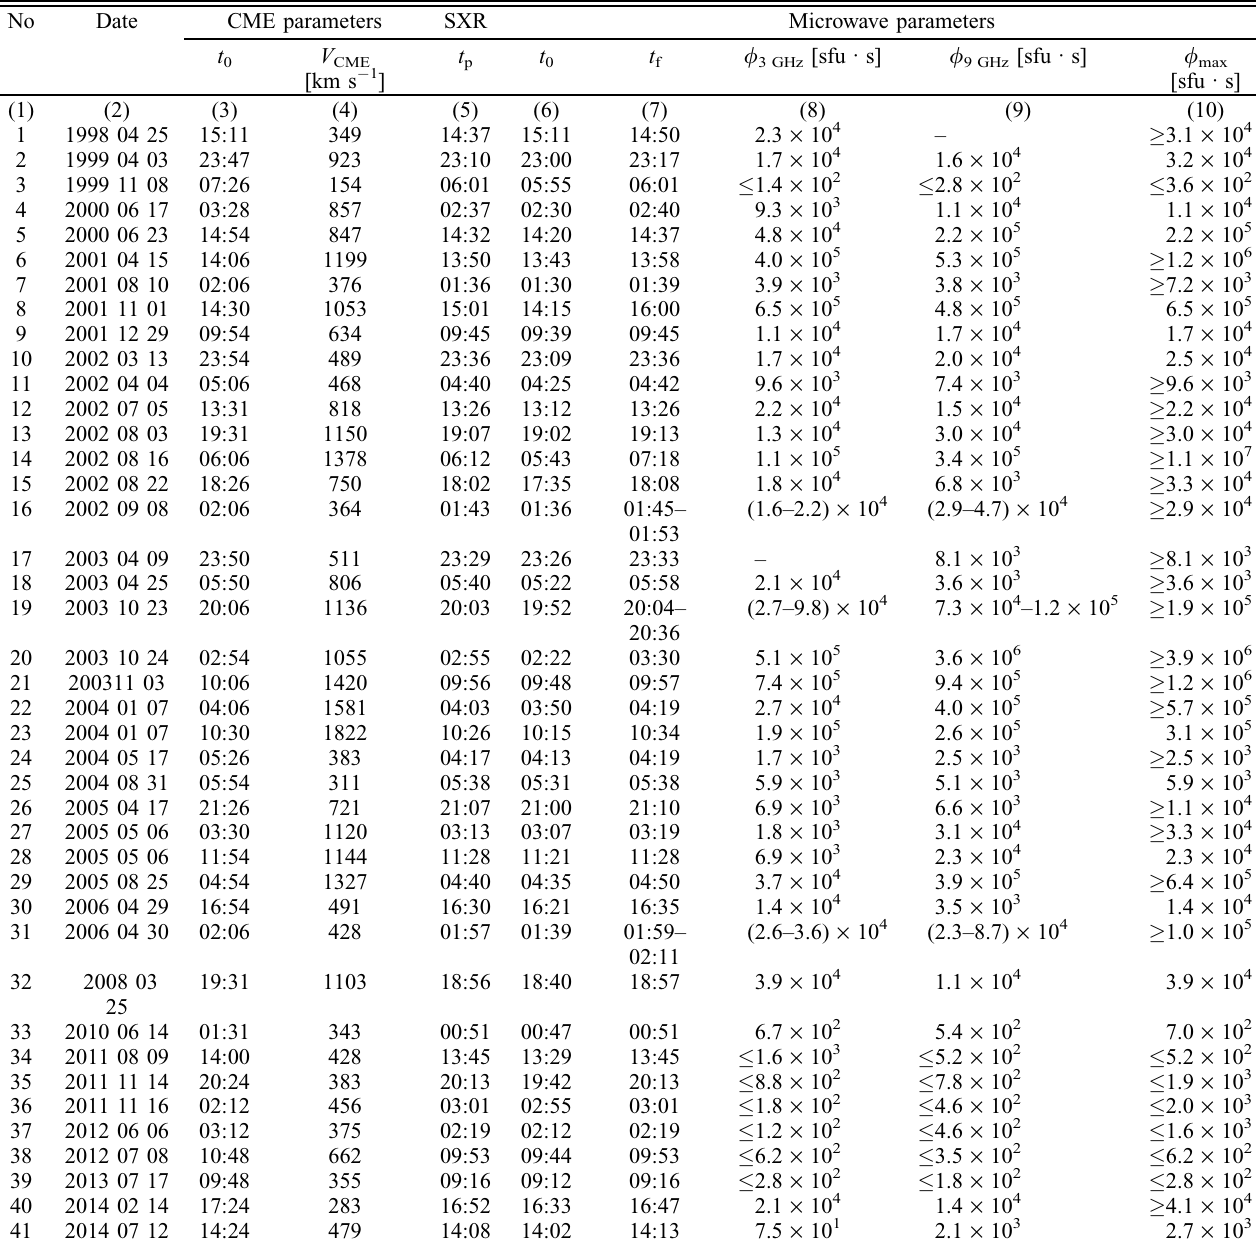
Table 1. Table of events: event number (col. 1), date (col. 2), time of the first appearance of the CME in LASCO/C2 coronograph (col. 3), CME speed in the plane of the sky reported in LASCO-CME (col. 4), SXR peak time (col. 5), times of onset (col. 6), end (col. 7), fluences at 3 GHz (col. 8), 9 GHz (col. 9), maximum (col. 10) of microwave bursts. Lower limits of the maximum fluence mean that the real maximum was outside the observed frequency